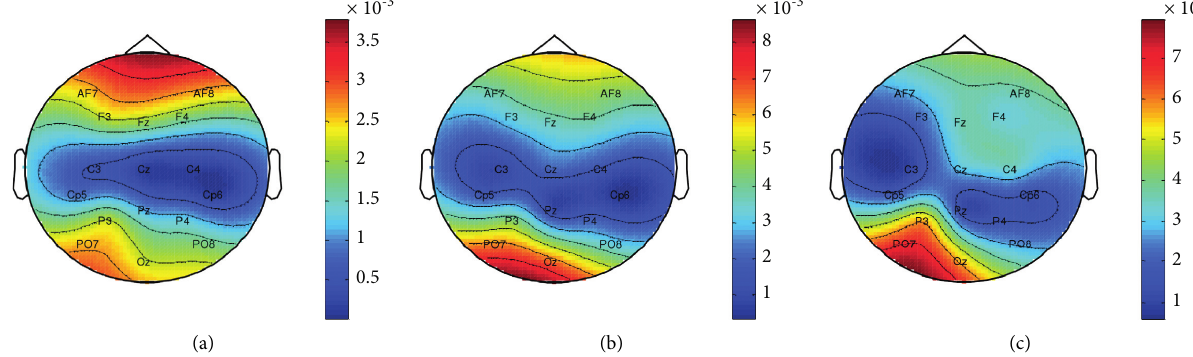
Figure 4: Emotion-related EEG topographic map. (a) Subject 1; (b) subject 2; (c) subject 3.